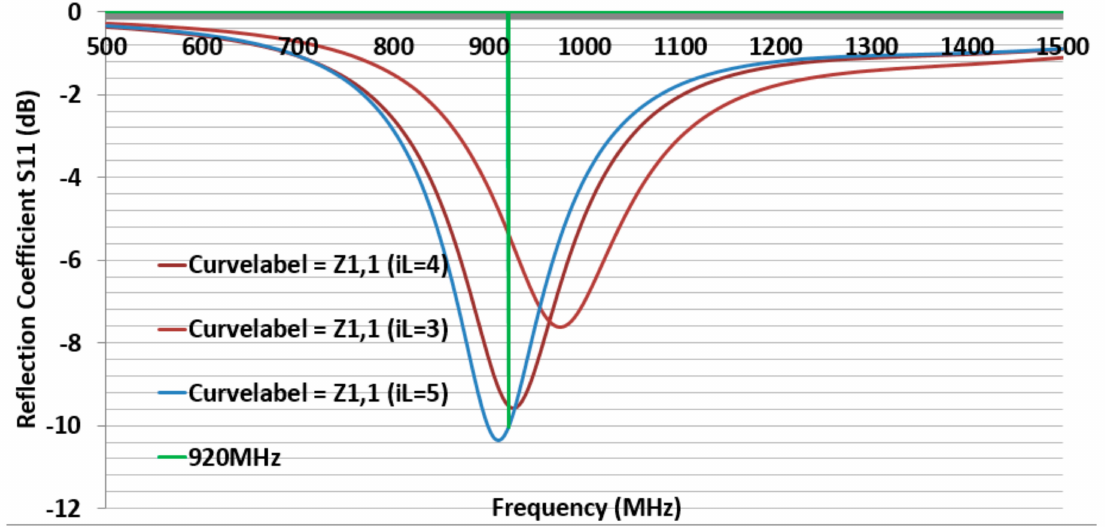
Figure 5. Return loss of the design CFTA P8040 by parameters of iL = 3, 4, 5